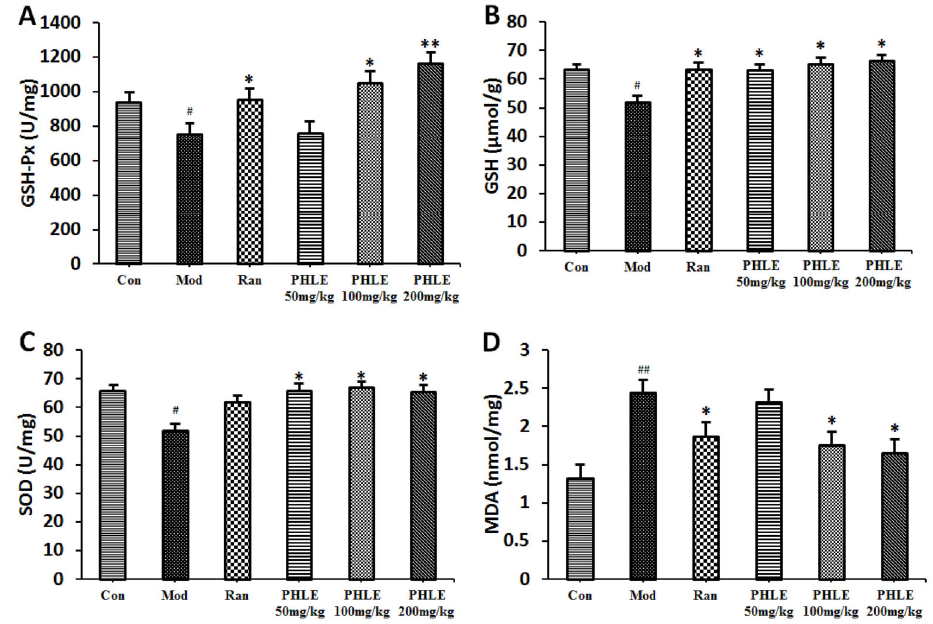
Figure 4. Effects of P. hydropiper extract (PHLE) on GSA-Px ( A ), GSH ( B ), and SOD ( C ) activity and MDA level ( D ) in gastric tissues from rats with ethanol-induced gastric damage. PHLE (50, 100, and 200 mg/kg) was used to pretreat rats. The data are reported as means ± SD (n=10). # P o 0.05 and ## P o 0.05 compared to the normal control group (Con); *P o 0.05 and **P o 0.01 compared to the model group (Mod) (ANOVA and LSD post hoc test). Ran: ranitidine (positive